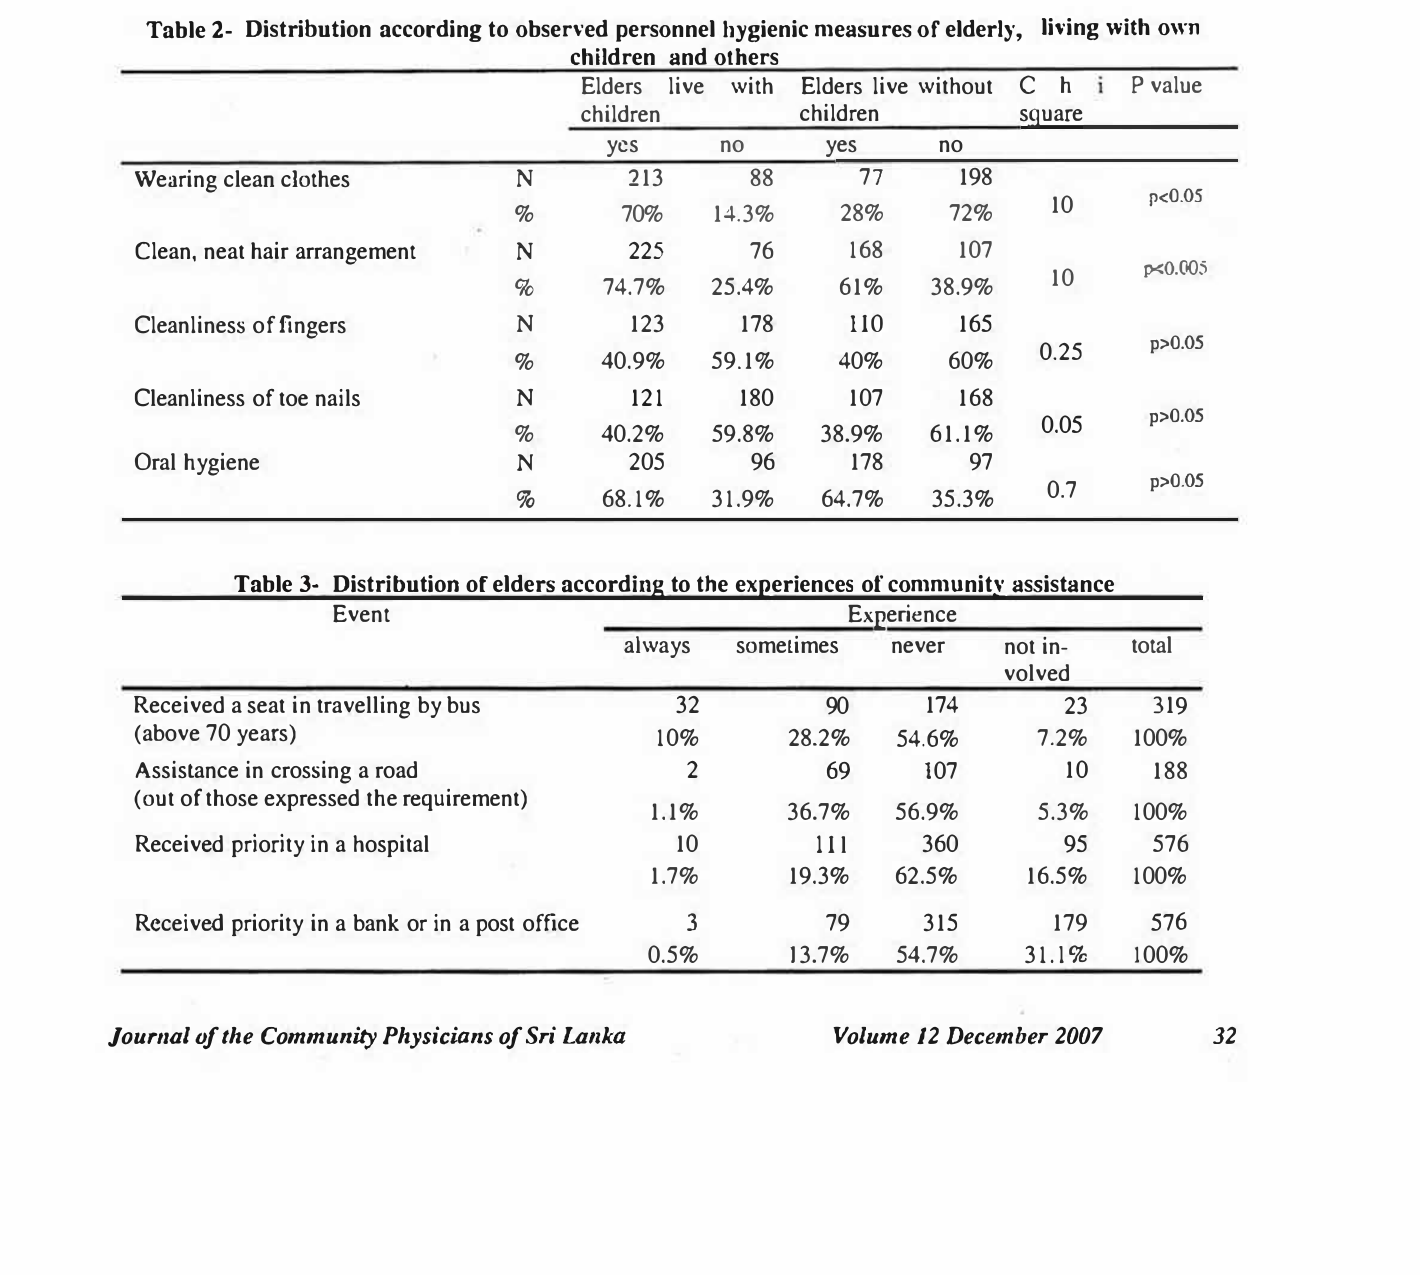
Table 2-Distribution according to observed personnel hygienic measures of elderly, living with ow11